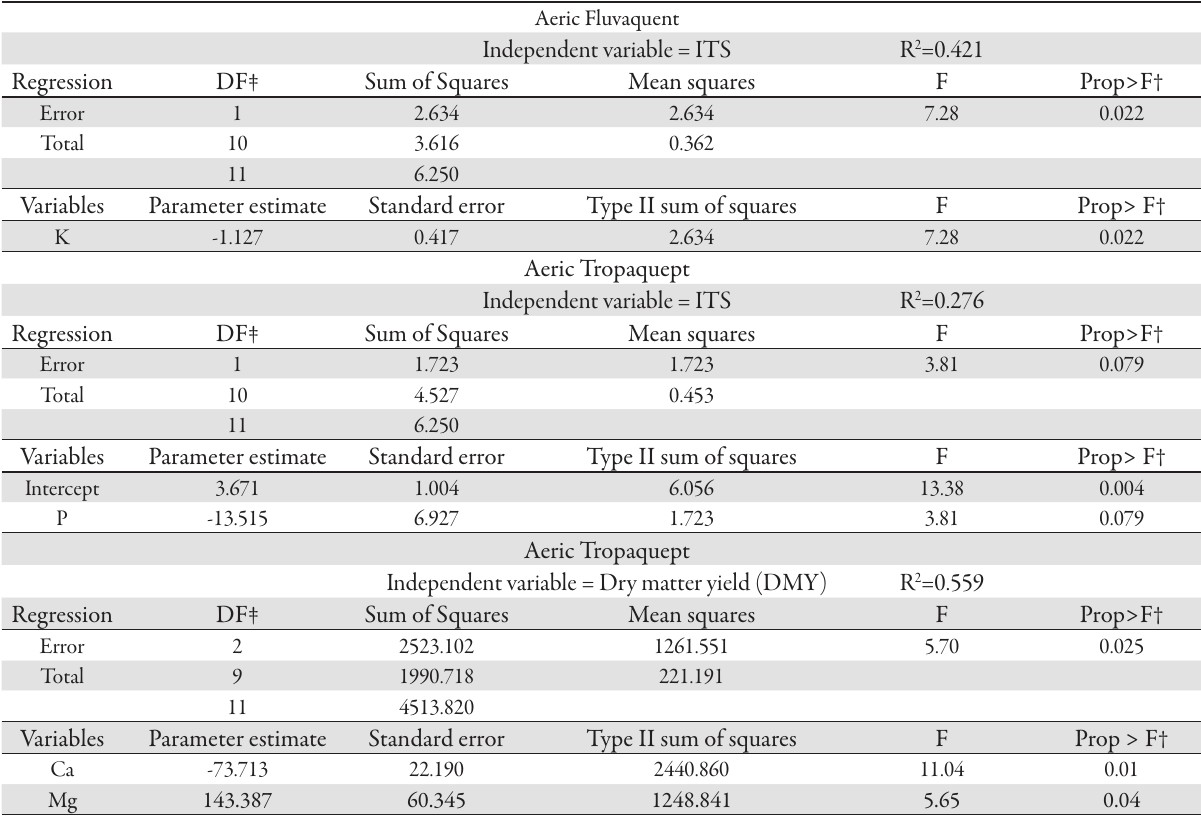
Table 1. Results of multiple regression analysis of the tolerant check (‘Suakoko 8’) on Aeric Fluvaquent and Aeric